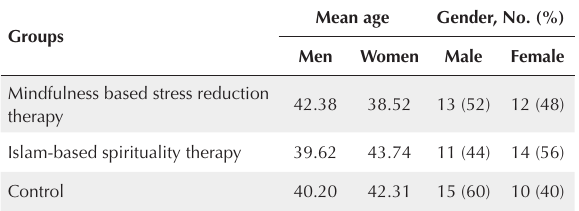
Mean age Gender, No.